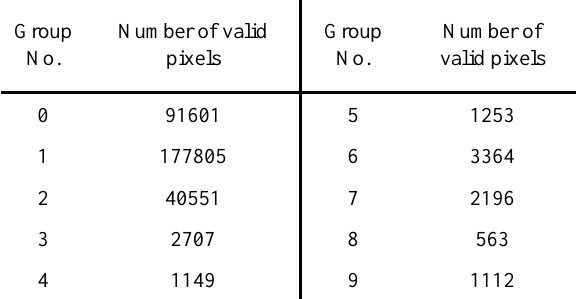
Table 1. The number of valid pixels in 10 groups obtained by the hierarchical processing.